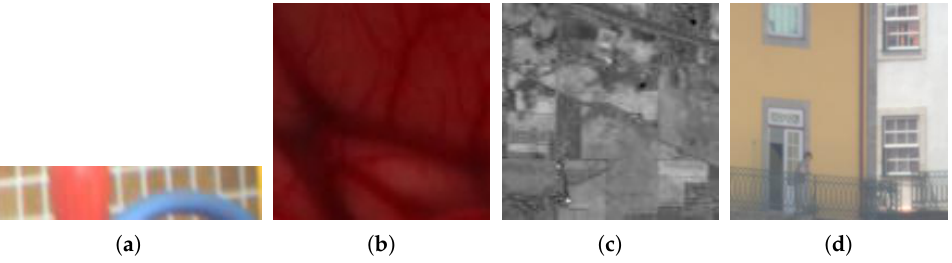
Figure 5. Scenes used in the experiments along with their size, their source and the values of ( µ x µ λ , p tk ). ( a ) “Toys” (30 × 150 × 31) [51]—(5, 0.5, 0.1). ( b ) “Brain” (100 × 100 × 100) [52]—(5, 0.5, 0.1). ( c ) “Indian pine” (100 × 100 × 100) [53]—(5, 0.5, 0.1). ( d ) “Urban” (200 × 200 × 33) [54]—(5, 0.7, 0.7).